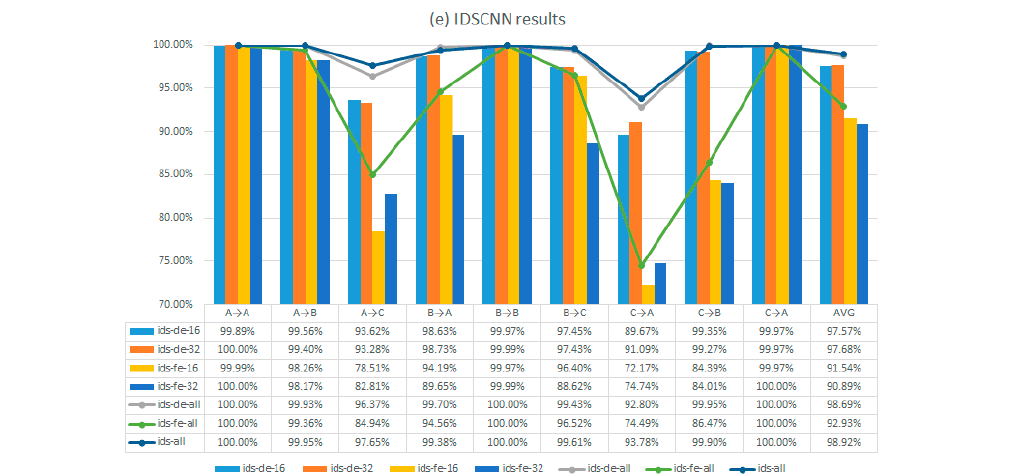
Figure 6. Results of the CNN Models and Proposed IDSCNN: ( a – d ) the results of individual CNNs trained with drive/fan end sensor signals and the IDS fusion results; and ( e ) IDSCNN results from fusion models with different component CNN models including fusing all 16 drive-end CNN models (ids-de-16, ids-de-32, and ids-de-all), fusing all 16 fan-end CNN models (ids-fe-16, ids-fe-32, and ids-fe-all), and fusing all models (ids-all).